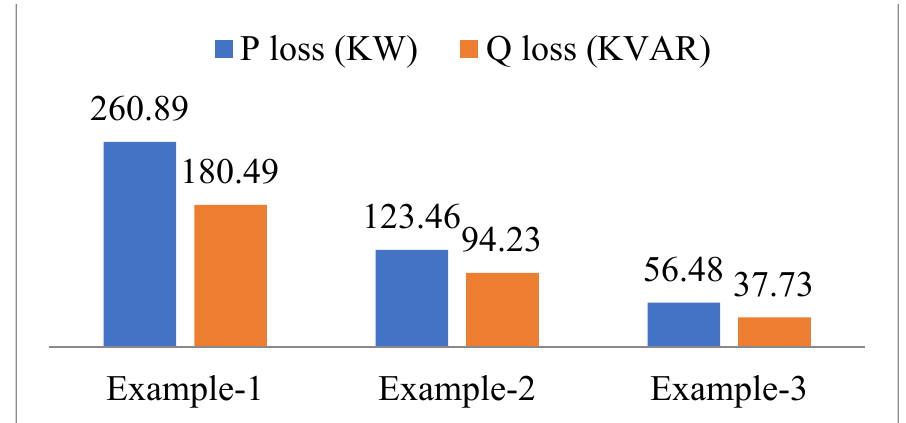
Figure 11. Voltage minimum in different study examples of the IEEE-34 bus URDN.